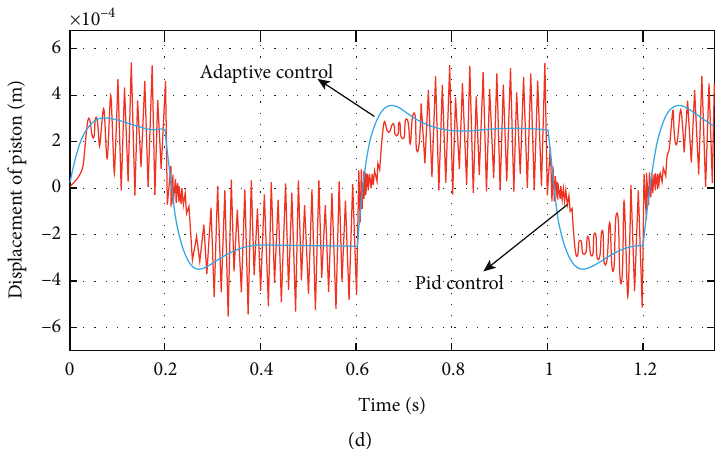
Figure 6: Comparison of results of different control methods: (a) no adaptive friction compensation system added; (b) add adaptive friction compensation system; (c) comparison of displacement errors between two control methods; (d) comparison of two control methods for piston